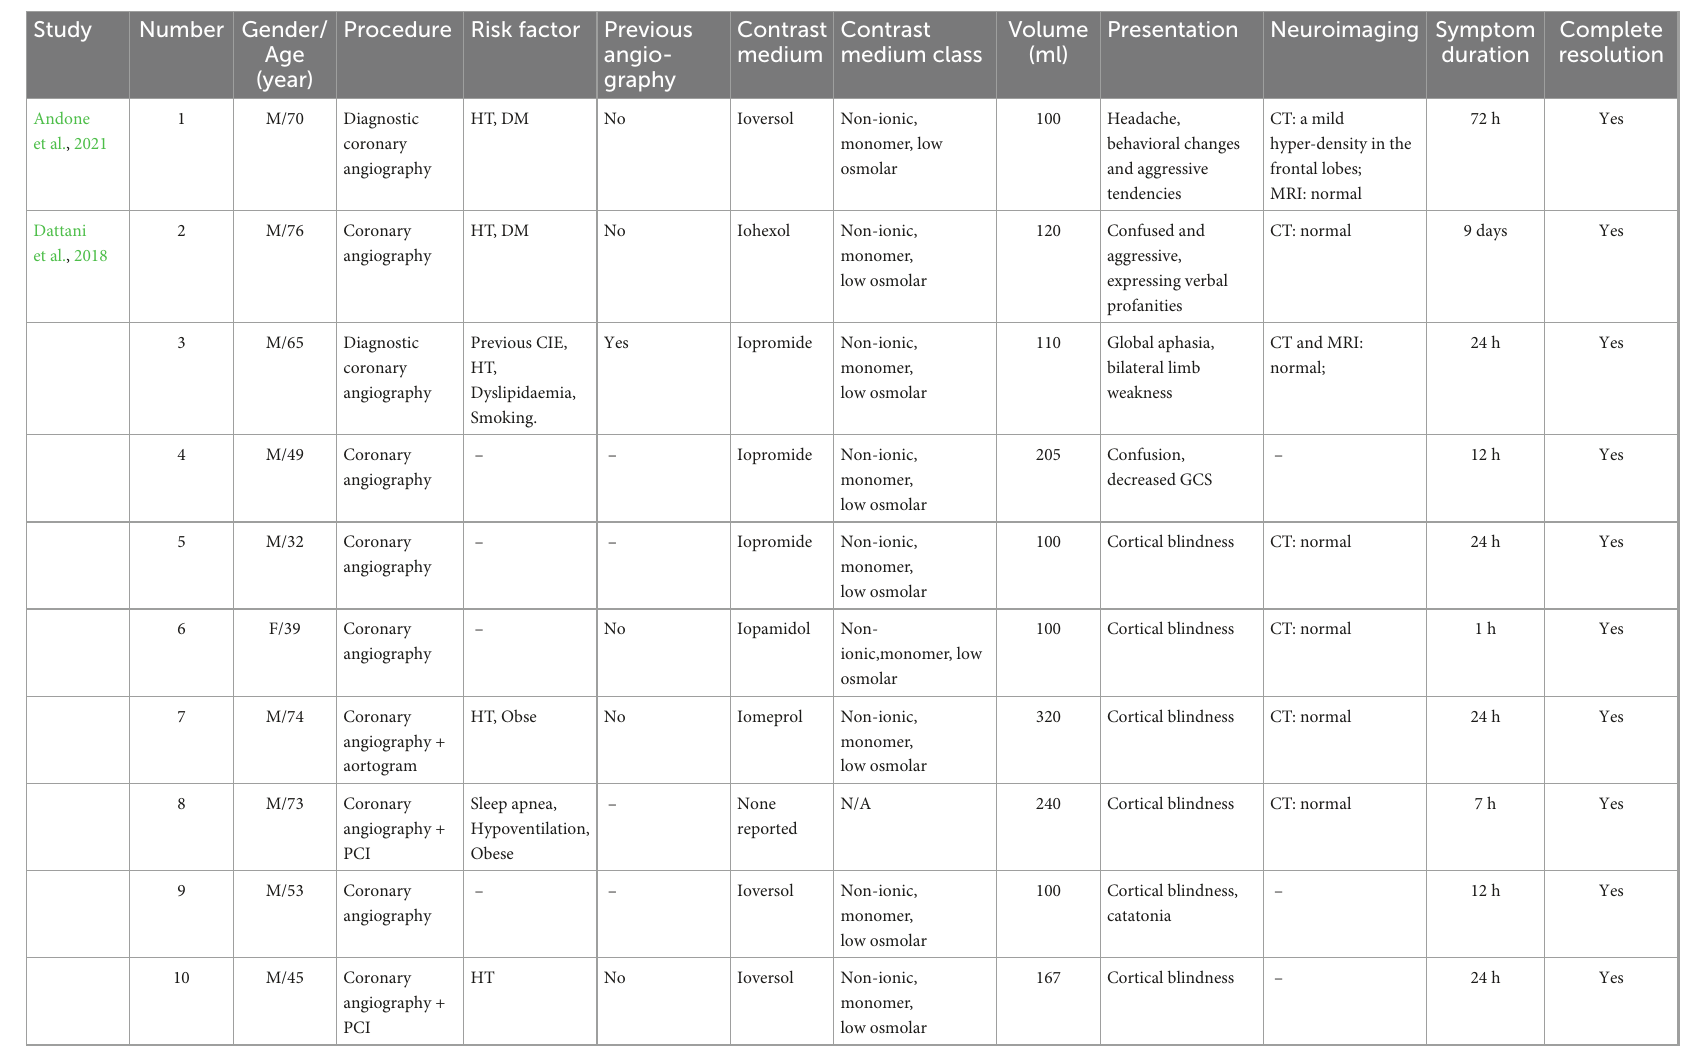
TABLE 1 Basic information of all